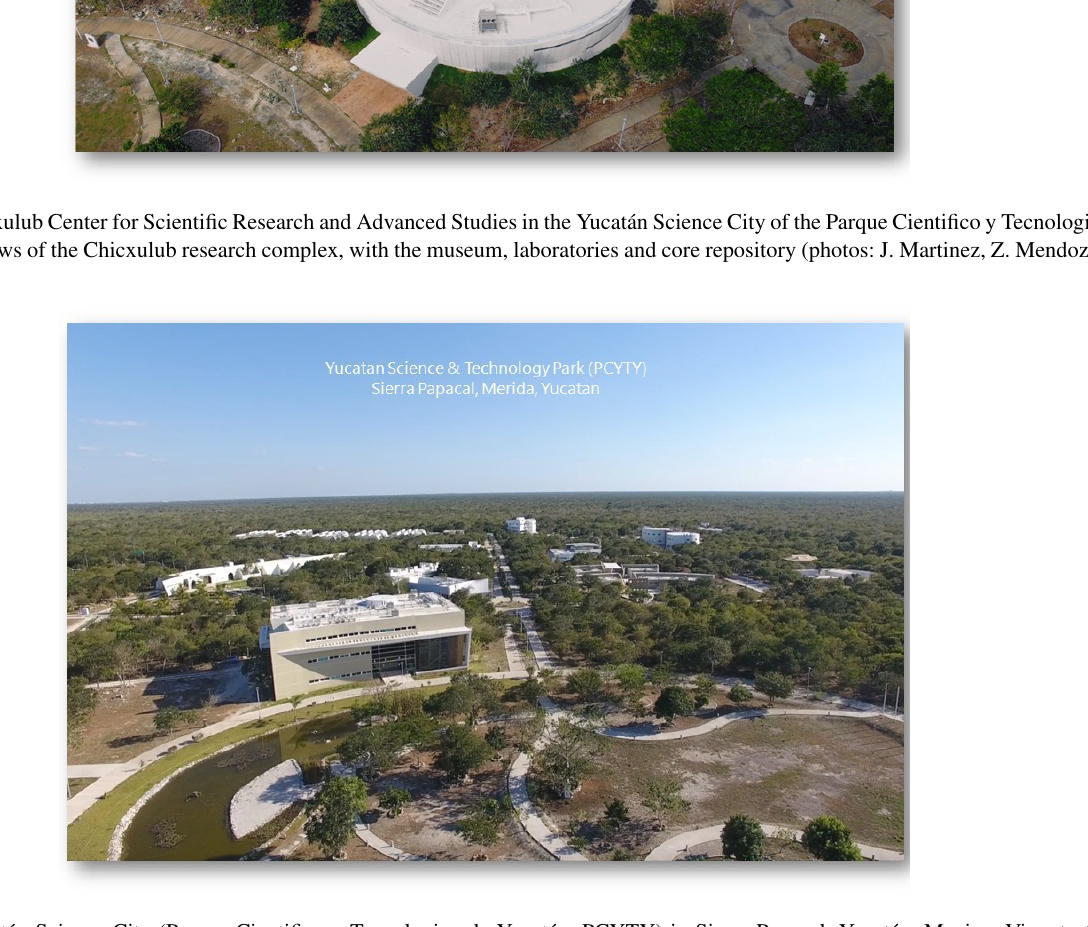
Figure 2. Yucatán Science City (Parque Cientifico y Tecnologico de Yucatán, PCYTY) in Sierra Papacal, Yucatán, Mexico. View to the south of the central PCYTY sector, with the central library building (drone image: Parque Cientifico y Tecnologico de Yucatán: https: //www.pcty.com.mx; last access: 12 October